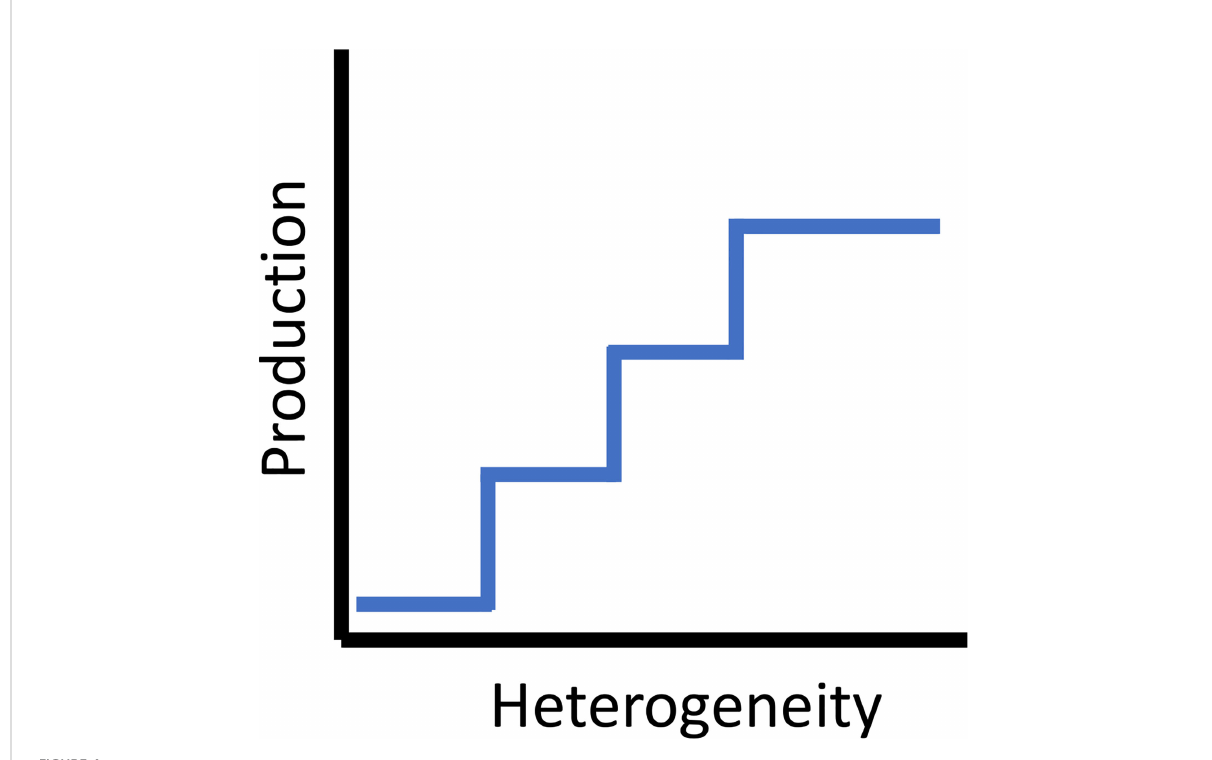
FIGURE 4 The theoretical step relationship between habitat heterogeneity and secondary ( fi sh)